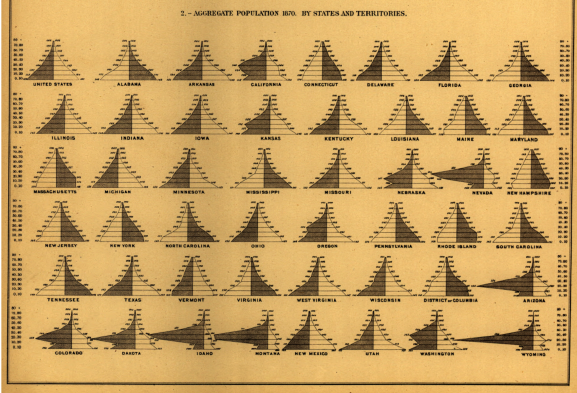
Figure 1: Age pyramids for different states (Plate 91, Statistical Atlas of the United States, 1870)